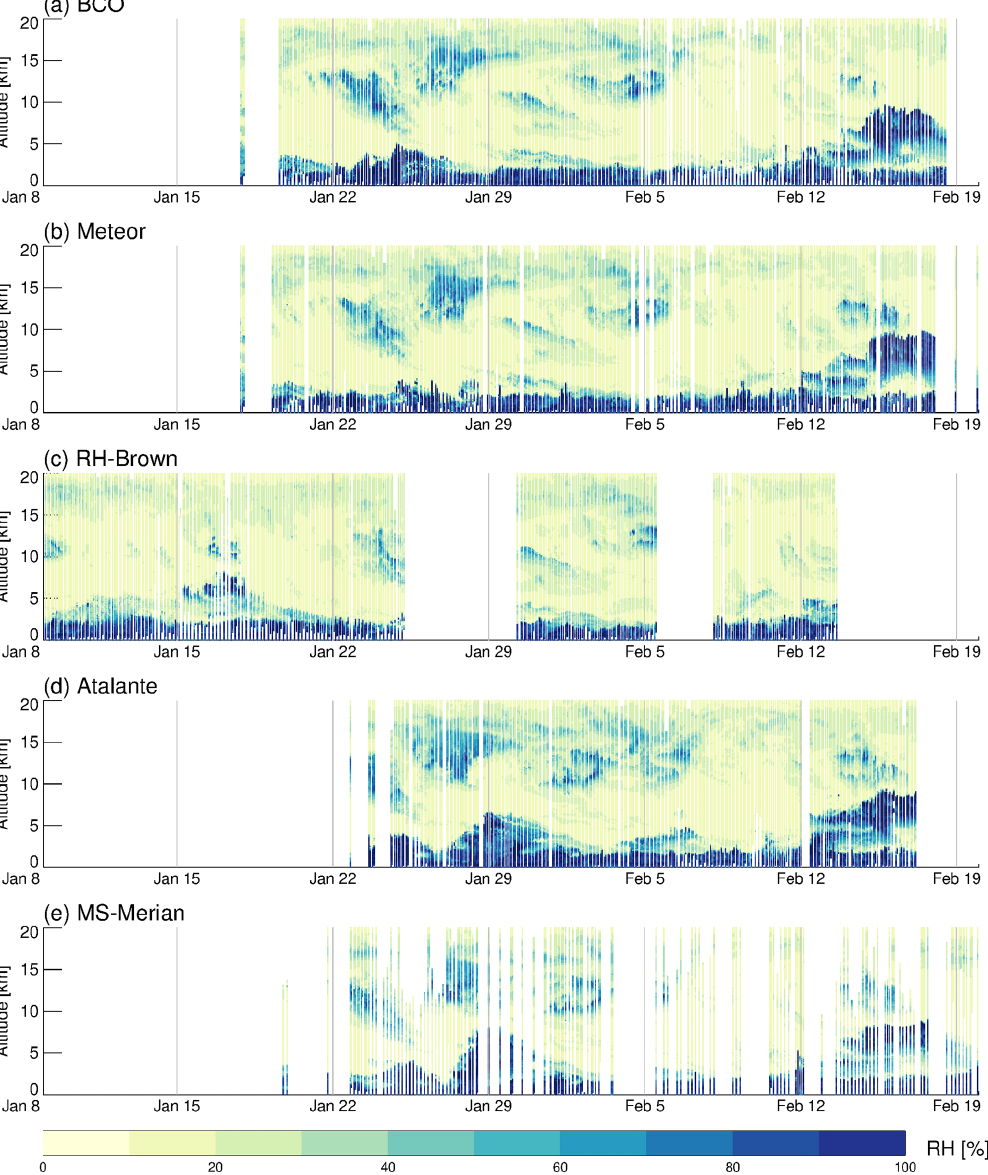
Figure 12. Time–height series of relative humidity measurements from all platforms. The plot combines ascending and descending sound-